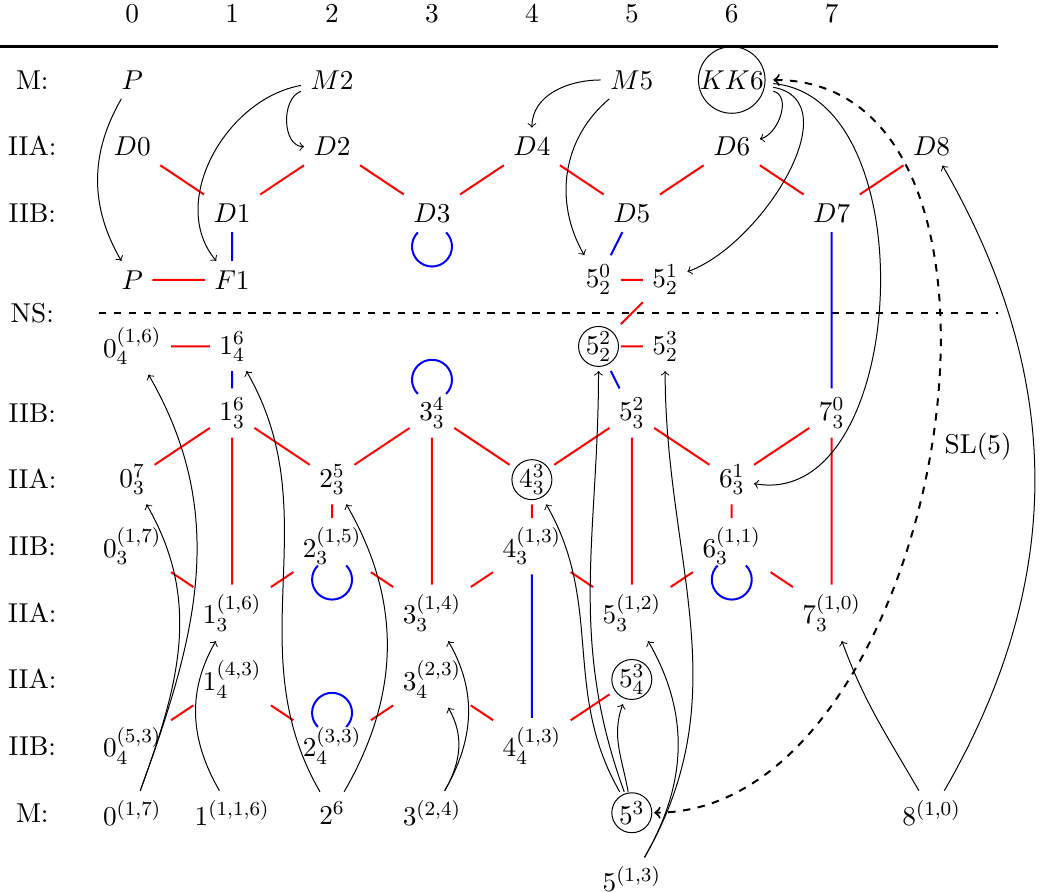
Figure 1 . Branes of Type II theories whose tension is proportional to g (cid:0) (cid:11) relations between them and the M-theory branes (only some of the branes with (cid:11) = 4 are shown). The black, red and blue arrows respectively denote reduction/oxidation, T-duality and